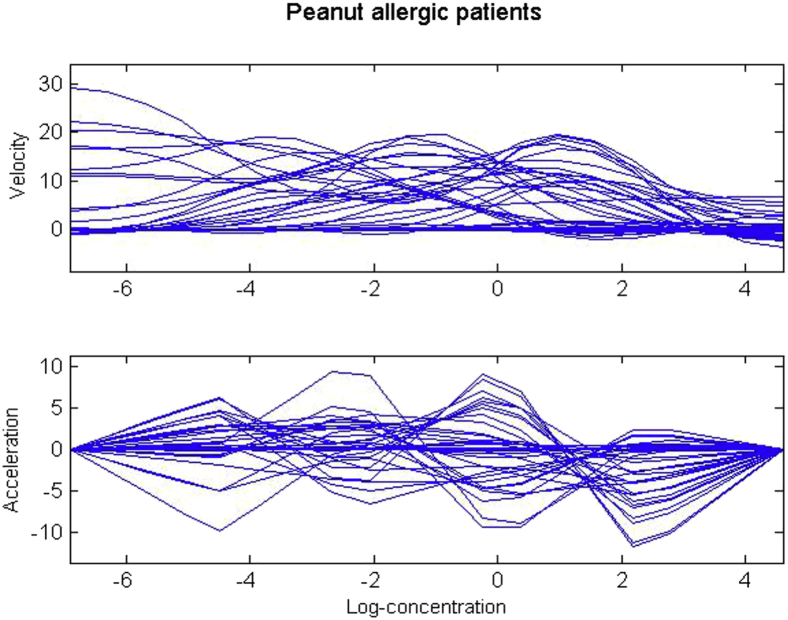
First and second derivatives of response curves for peanut-sensitized patients.